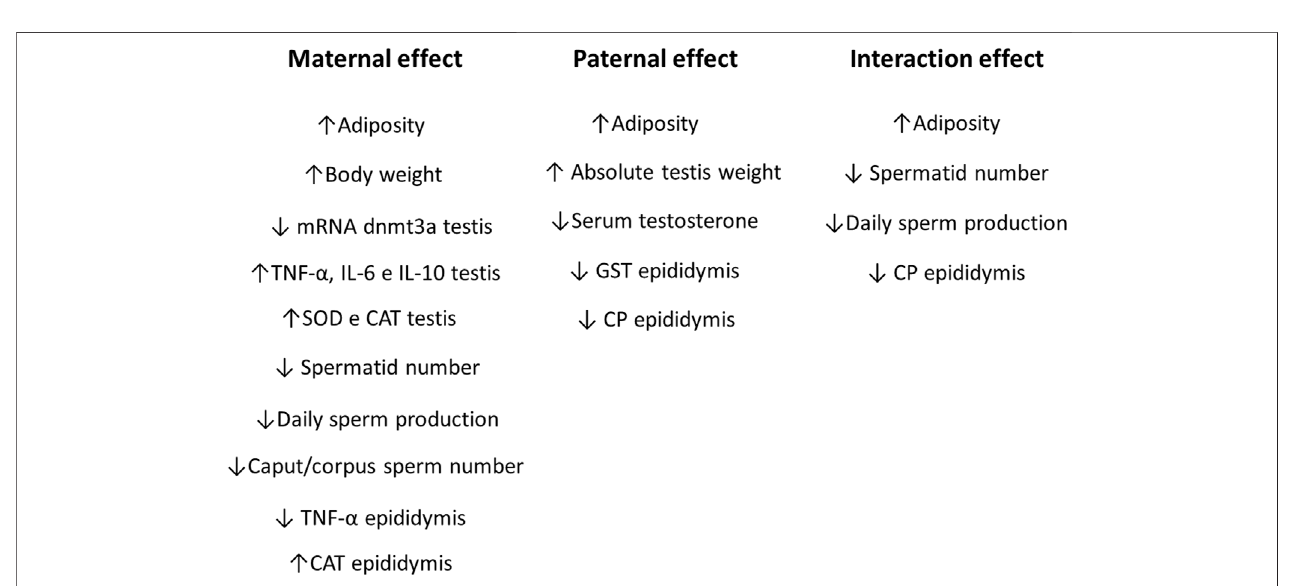
FIGURE 9 | Maternal, paternal, and interaction effects in male rat offspring from progenitors fed on high-fat and high-sugar diet.